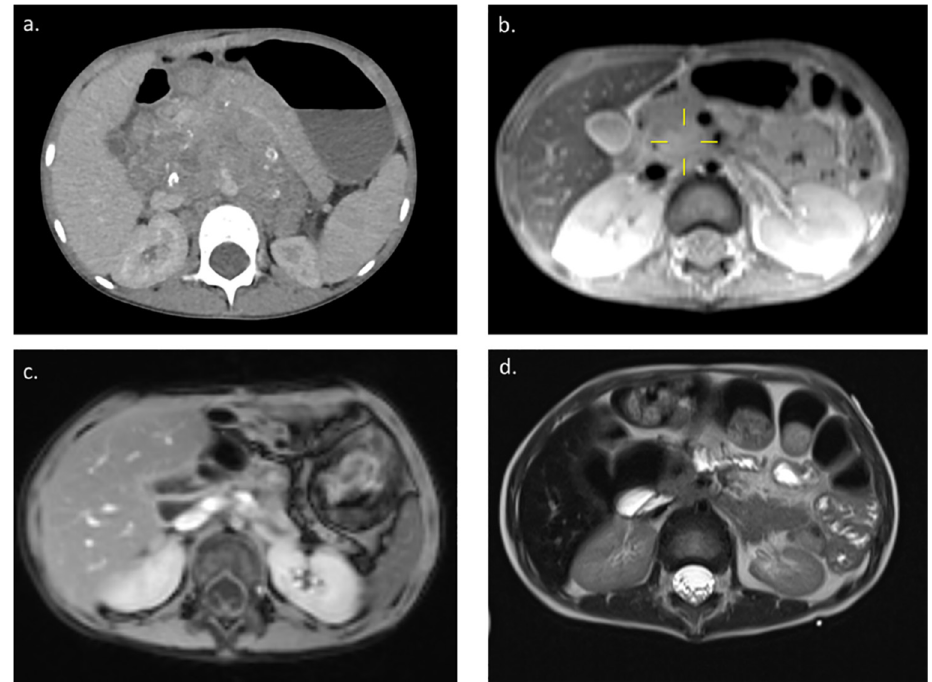
Figure 1. Contrast-enhanced computed tomography image of the abdomen of a girl, three years and six months of age, with high-risk neuroblastoma ( a ) at diagnosis, ( b ) prior to surgery (following rapid COJEC induction chemotherapy), ( c ) prior to receiving dinutuximab beta (after surgery, myeloablative chemotherapy, autologous stem cell transplant, and radiotherapy), and ( d ) after receiving dinutuximab beta. COJEC, cisplatin (C), vincristine (O), carboplatin (J), etoposide (E), and cyclophosphamide